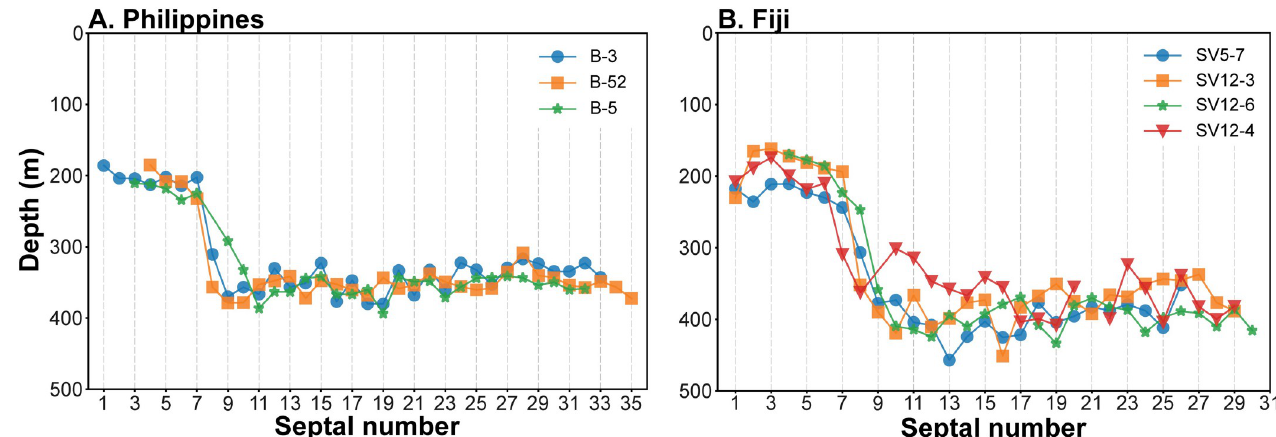
Fig 9. Reconstructed habitat depth of Nautilus pompilius from the Philippines and Fiji. Depth vs. septal number in the Philippines (A) and Fiji (B), based on the δ 18 O ar vs. depth relationships. Data from Oba et al. [16] and Hayasaka et al. [43,